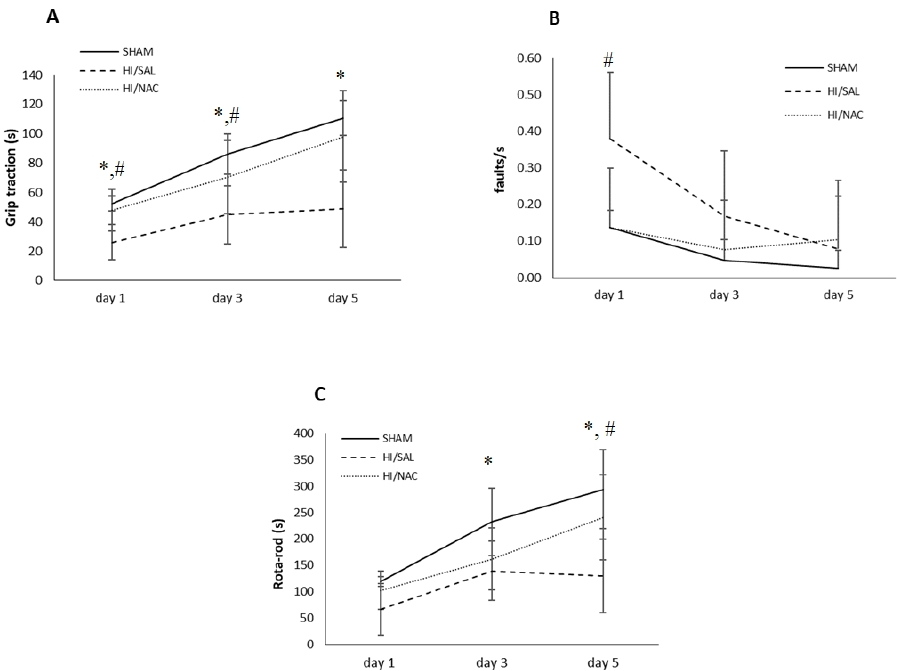
Figure 1. ( A ) Grip traction, ( B ) Foot-fault and ( C ) Rota-Rod test of SHAM-operated, HI/SAL and HI/NAC treated animals during the 3 days of observation period. Data are presented as mean ± SD. (*) p < 0.05 HI/SAL vs. SHAM group, (#) HI/SAL vs. HI/NAC group.